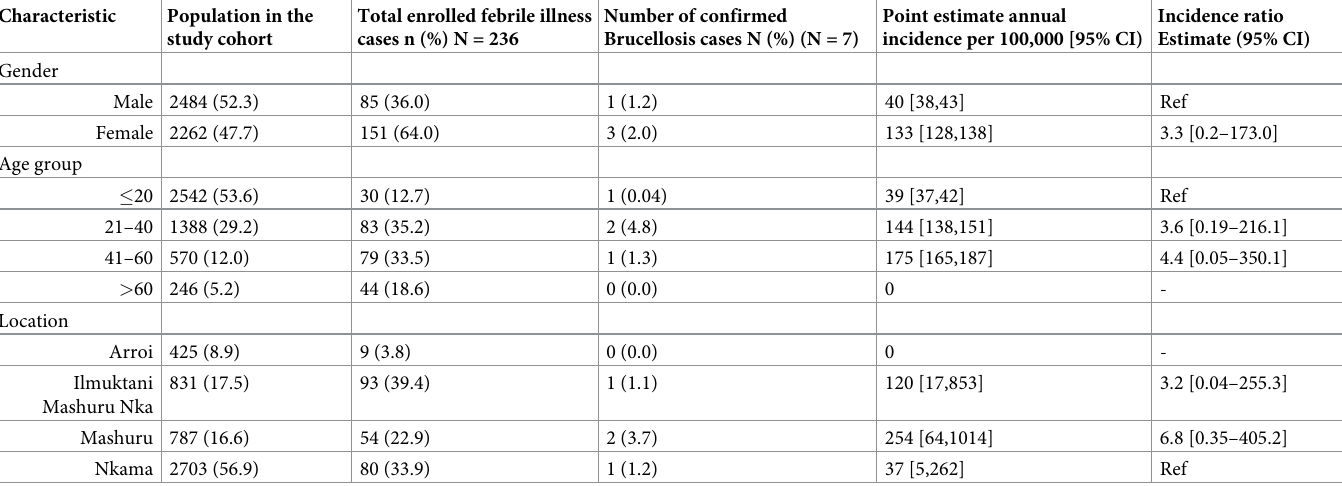
Table 5. Annual Incidence of brucellosis in humans by gender, age and location in Kajiado Kenya, 2015–2016.